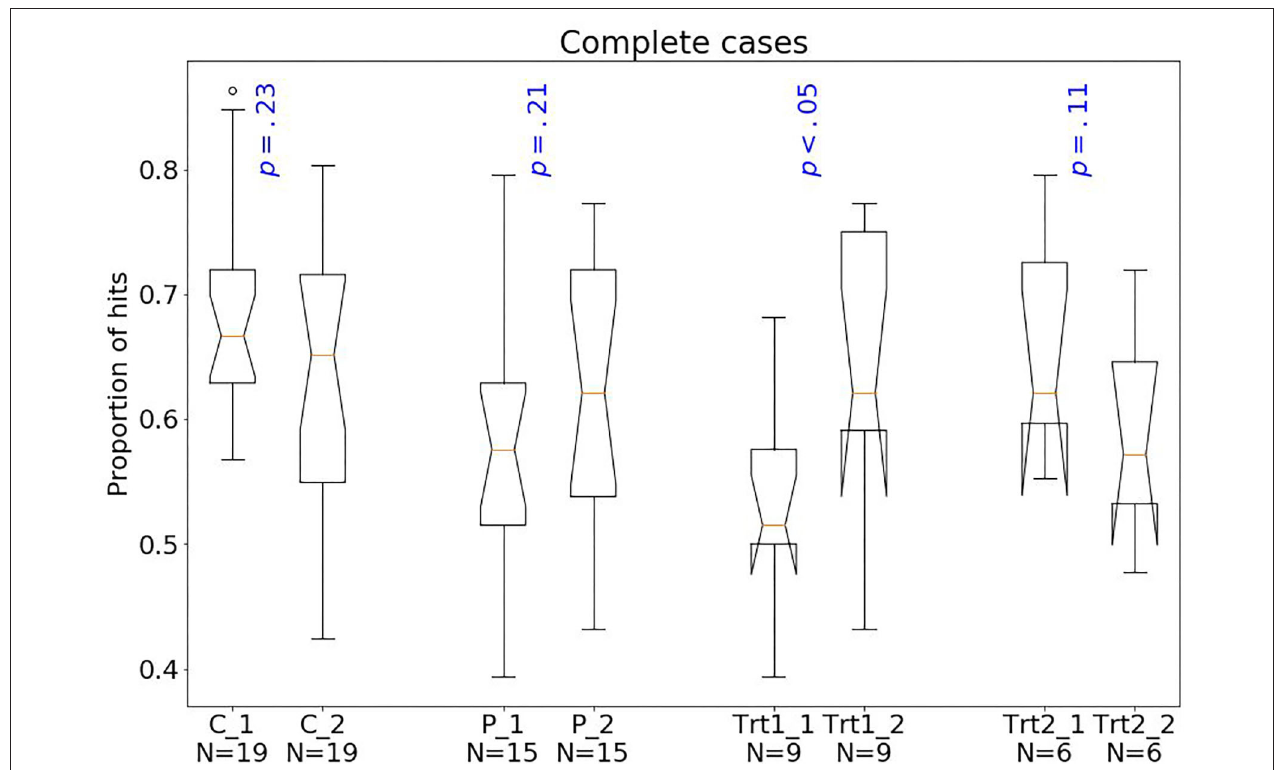
FIGURE 4 | Box plots of the PRL task. The horizontal line represents the median; the boxes extend to the first and third quartile, while whiskers extend to the max/min or the corresponding quartile + 1.5 IQR. C, healthy controls; P, patients with MUD; Trt_1, successful treatment outcome; Trt_2, unsuccessful treatment outcome. Box plots of proportion of hits.